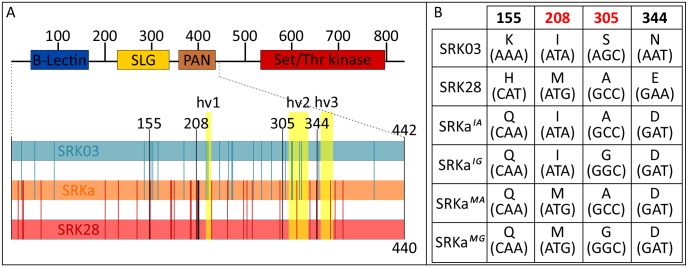
Comparison between the S-domain of AhSRK03 and AhSRK28 and their common ancestor.(A) Arrangement of domains in the full-length SRK protein as assigned by National Center for Biotechnology Information (upper) and protein schematic representation of the S-domain sequence of AhSRK03, AhSRK28 and their common ancestor SRKa (lower). Positions of identical amino acids between the three S-domains are not represented, positions of SRKa amino acids specific to SRK03 and SRK28 are represented by a vertical blue and red line respectively. Positions of hypervariable regions are represented by yellow rectangles. The position of the two amino acid gap presents in both AhSRKa and AhSRK03 is represented by black rectangles. Positions 208 and 305 for which the reconstruction was uncertain and positions 155 and 344 for which the aa identity is different in the two other receptors are represented in black. (B) Amino acid identity and codon sequence (in parentheses) for these four positions in the different SRK variants.